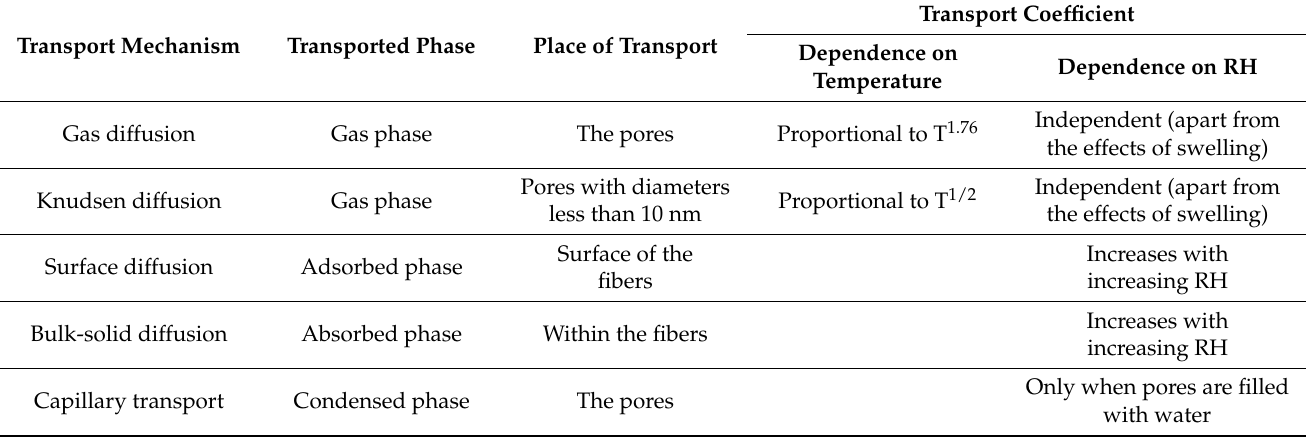
Table 5. Possible mechanisms for moisture transport through